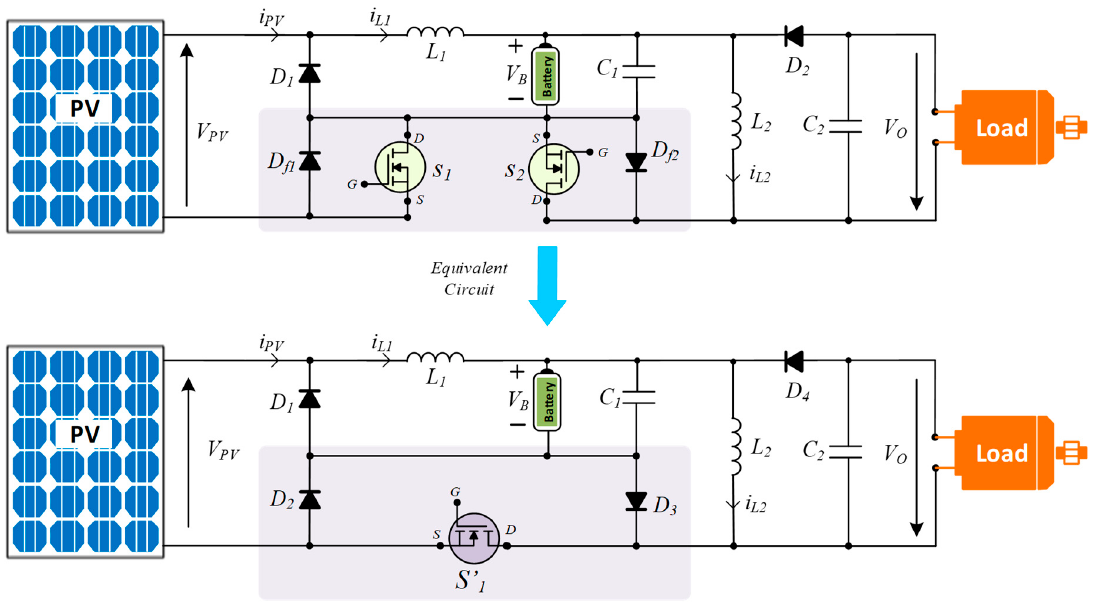
Figure 5. Two ‐ stage DC ‐ DC converter ( top ) and its equivalent single switch circuit ( bottom ).